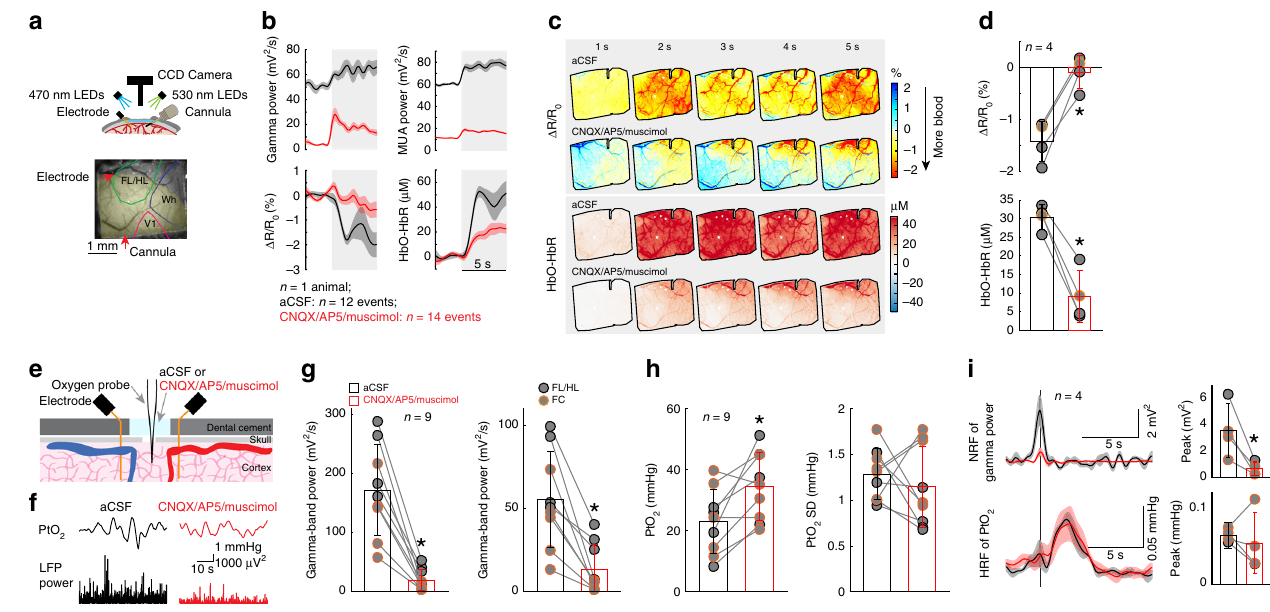
Fig. 3 Locomotion-evoked cortical oxygenation increases persist when vasodilation is blocked. a Experimental setup for spectroscopy. b Locomotion- evoked gamma-band LFP power (top left), MUA power (top right), Δ R/R 0 (bottom left) and HbO-HbR (bottom right) in one representative mouse following aCSF (black, 12 locomotion events) and CNQX/AP5/muscimol (red, 14 locomotion events) infusion. c Locomotion-evoked spatial distribution of Δ R/R 0 (top) and HbO-HbR (bottom) for the same mouse shown in ( a ) and ( b ) following aCSF and CNQX/AP5/muscimol infusion. d Group average of locomotion-evoked Δ R/R 0 (top, * paired t -test, t (3) = 7.4235, p = 0.0051) and HbO-HbR (bottom, * paired t -test, t (3) = 8.0007, p = 0.0041) after aCSF or CNQX/AP5/muscimol infusion in four mice. The orange circle denotes the mouse shown in ( b ) and ( c ). e Experimental setup for simultaneous PtO 2 and LFP measurements. f Example of resting PtO 2 fl uctuations (top) and resting gamma-band LFP fl uctuations (bottom) in FL/HL in a single mouse. g Comparison of spontaneous LFP activity (left, * Wilcoxon signed-rank test, p = 0.0039) and fl uctuations (SD, right, * paired t -test, t (8) = 5.0246, p = 0.0010) before (black) and after (red) application of CNQX/AP5/muscimol in FL/HL (4 mice, black circle) and FC ( fi ve mice, orange circle). h As ( g ) but for spontaneous PtO 2 activity (left, * paired t -test, t (8) = 3.2712, p = 0.011) and fl uctuations (SD, right, * paired t -test, t (8) = 0.7542, p = 0.4723). i Top left, NRF of gamma-band LFP power ( n = 4 mice, 1 in FL/HL and 3 in FC) before and after application of CNQX/AP5/muscimol. Vertical black line indicates the start of a brief impulse of locomotion. Bottom left, as in top left but for HRF of PtO 2 . Top right, peak amplitude of NRF of gamma-band LFP power before and after application of CNQX/AP5/muscimol (*paired t -test, one sided, t (3) = 3.4299, p = 0.0208). Bottom right, as in top right but for peak amplitude of HRF of PtO 2 (paired t -test, t (3) = 0.5861, p = 0.599). Solid lines and shaded area in ( b ) and ( i ) denote mean ± SEM, respectively. Data are shown as mean ± SD in all other